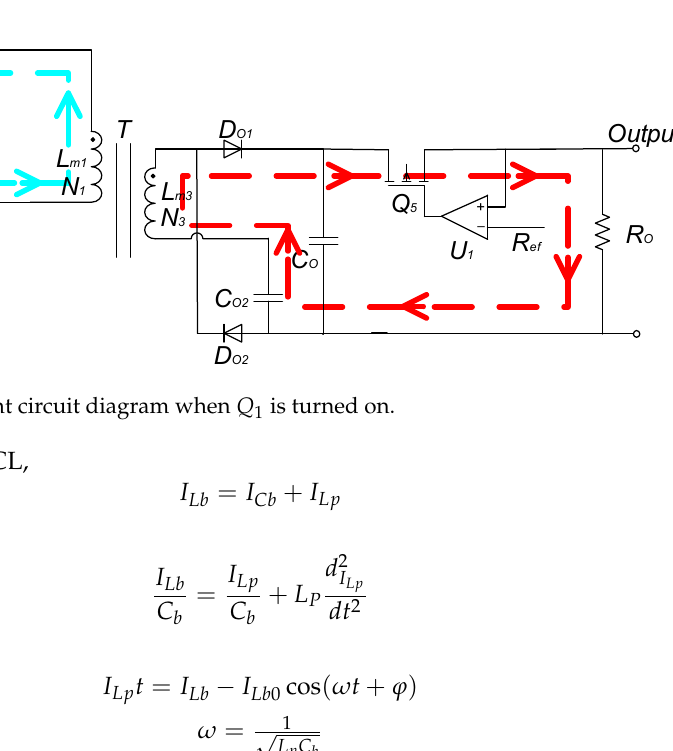
When 𝑄 (cid:2869) is turned on, energy transfers from the primary side to the secondary side, with the equivalent circuit diagram shown in Figure 6. In Figure 6, the green and blue arrows indicate the direction of current flow on the primary side, the red arrows indicate the direction of current flow on the secondary side.